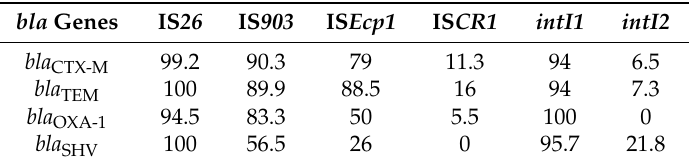
Table 4. Prevalences of insertion sequences and integrons among the different types of ESBL- E. coli